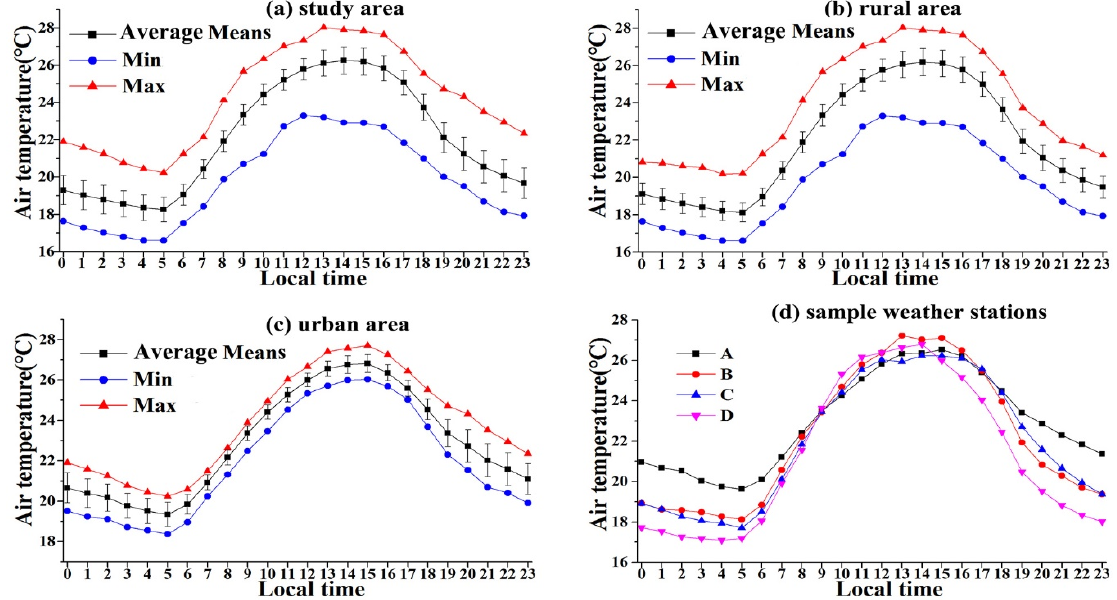
Figure 4. Hourly variations of maximum (Max), minimum (Min) and mean air temperatures of study area, rural area, urban area, and the averaged mean air temperature of four sample weather stations.